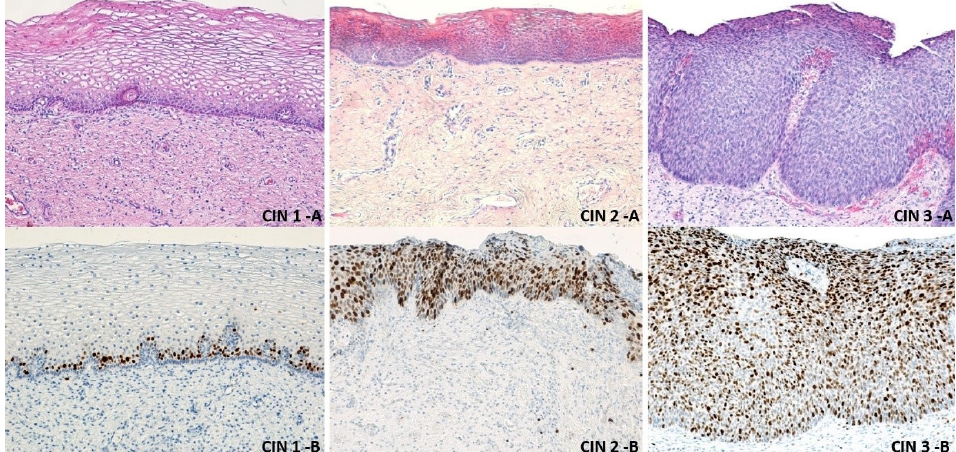
Figure 8. Microscopic aspects of cervical intraepithelial neoplasia. CIN 1- A: non-keratinized stratified squamous epithelium with low-grade dysplastic lesions in the basal layer. Classical stained hematoxylin–eosin x 100; CIN 1- B: non-keratinized stratified squamous epithelium with low-grade dysplastic lesions in the basal layer, with the nucleus of the cells immunostained with the Ki-67 antibody x 100; CIN 2- A: non-keratinized stratified squamous epithelium with middle-grade dysplastic lesions in the basal and intermediate layers. Classical stained hematoxylin–eosin x 100; CIN 2 -B: non-keratinized stratified squamous epithelium with middle-grade dysplastic lesions in the basal and intermediate layers, with the nucleus of the cells immunostained with the Ki-67 antibody x 100; CIN 3 -A: non-keratinized stratified squamous epithelium with severe dysplastic lesions in all the tissue layers. Classical stained hematoxylin–eosin x 100; CIN 3 -B: non-keratinized stratified squamous epithelium with severe dysplastic lesions in all the tissue layers, with the nucleus of the cells immunostained with the Ki-67 antibody x 100; CIN: cervical intraepithelial neoplasia.